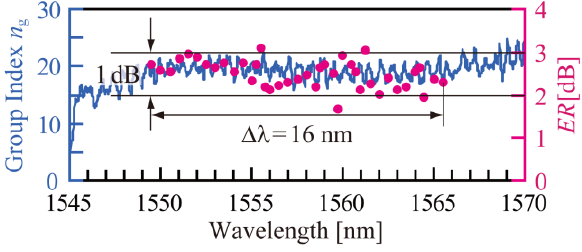
Figure 6. Spectra of n g and ER measured at 25 Gbps. Operating condition was similar to that for Figure 5.